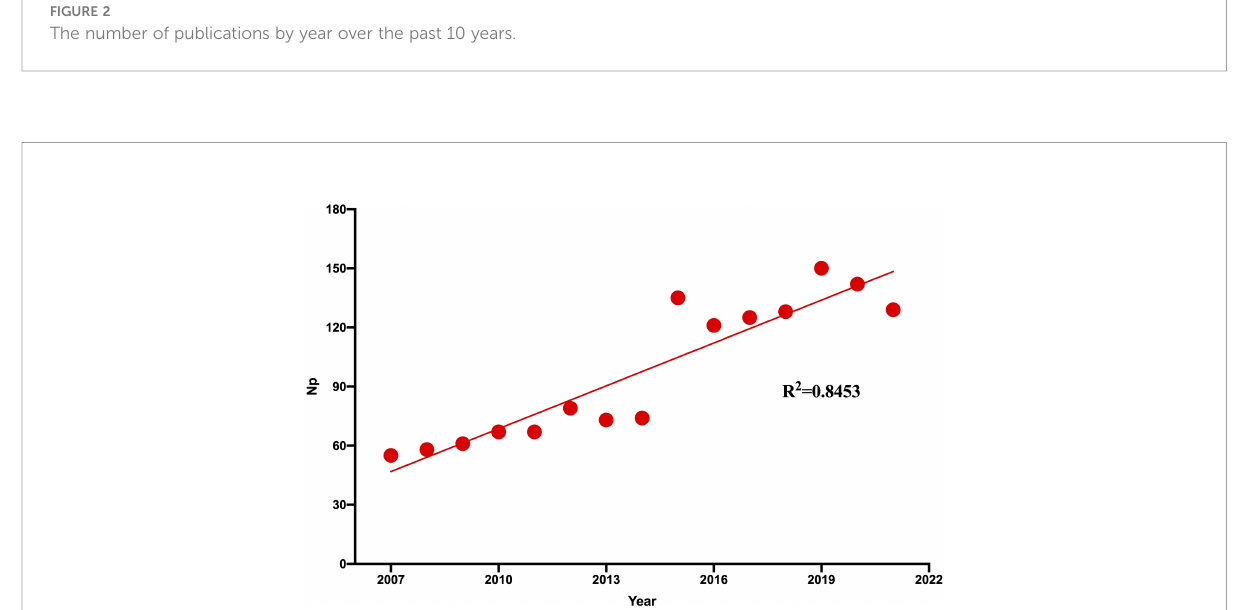
FIGURE 3 Curve fi tting of the of the total annual growth trend of publications (R2 = 0.8453).